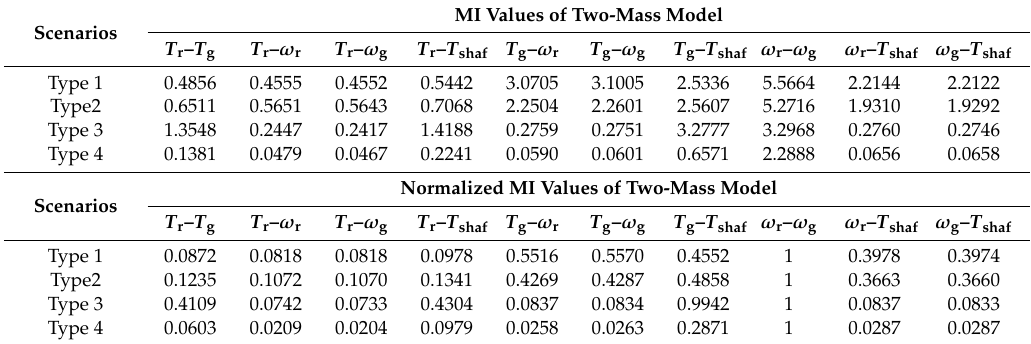
Table 3. Mutual information (MI) values of two-mass model under di ff erent wind scenarios.